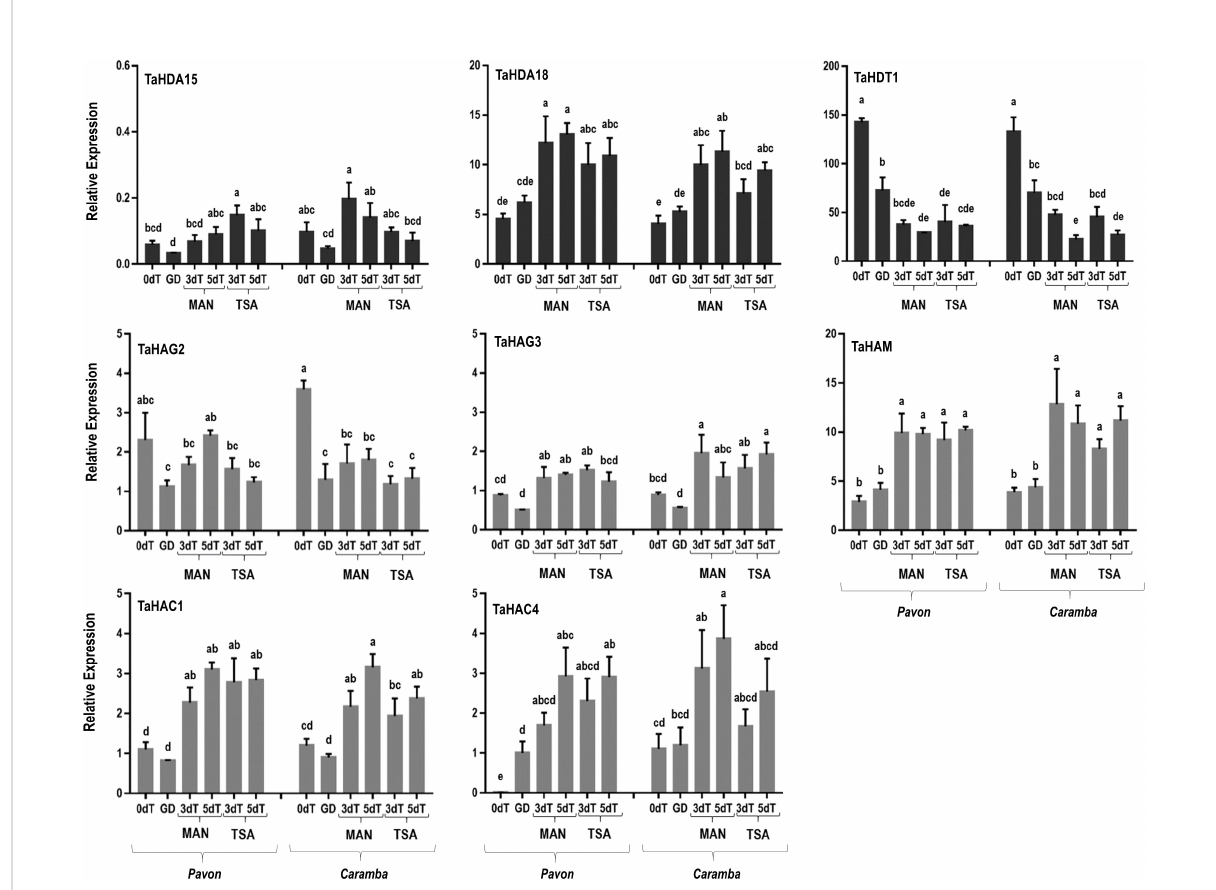
FIGURE 4 qRT-PCR analysis of histone deacetylases genes ( TaHDA15 , TaHDA18 , TaHDT1 , TaHDT2 , TaTAF14 ) and histone acetyltransferases genes ( TaHAG2 , TaHAG3 , TaHAM , TaHAC1 , TaHAC4 ) in microspore before stress treatment (0dT), microspores under gametophytic development (GD), microspores after 3 and 5 days with mannitol treatment (3dT-MAN, 5dT-MAN) and after 3 and 5 days with mannitol plus TSA treatment (3dT- TSA, 5dT-TSA) from Pavon (on the left) and Caramba (on the right). Data were normalized using Ta.27771 and Ta.2291 as endogenous control genes. Bars represent the standard errors of the means. Relative expression values with the same letter are not signi fi cantly different (P<0.05) according to the Duncan